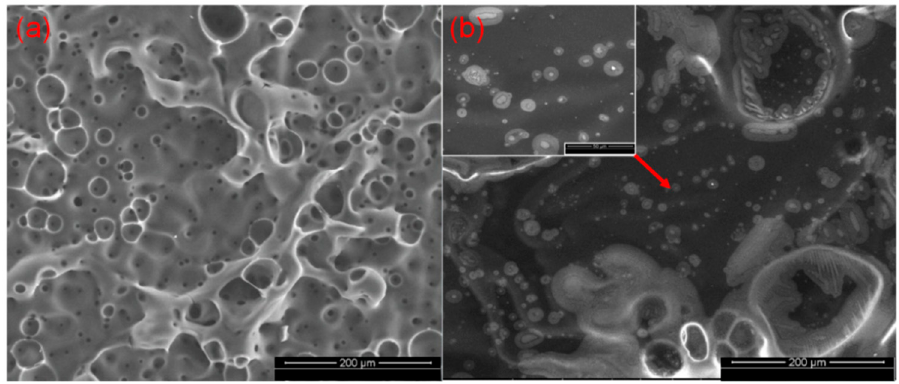
Figure 9. SEM images of the char residues for ( a ) BADPS0 and ( b ) BADPS20.